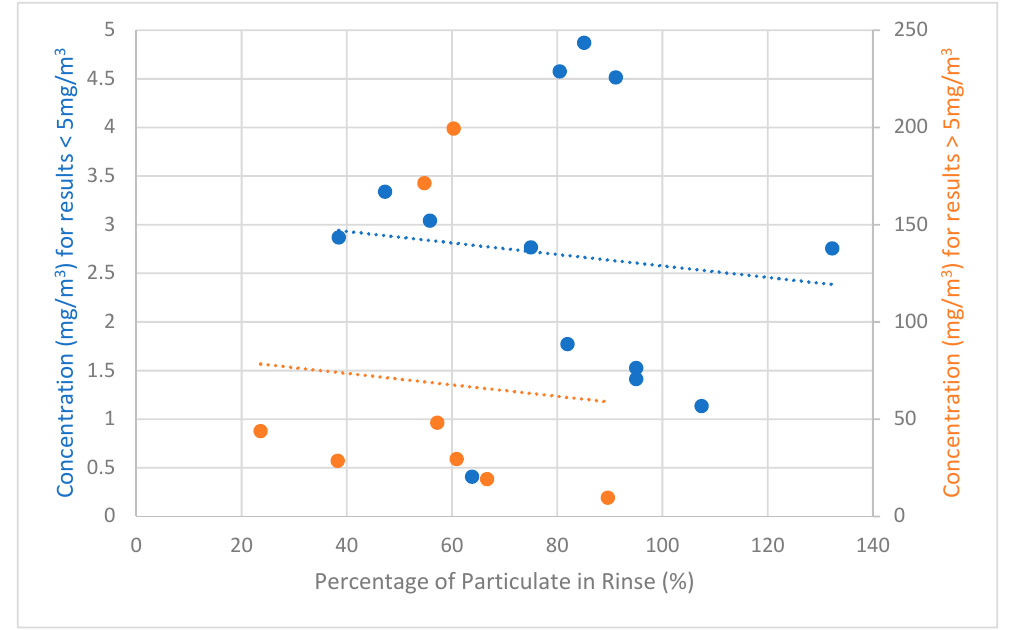
Figure 7. Percentage of mass in rinse (%) and concentration (mg/m 3 ).